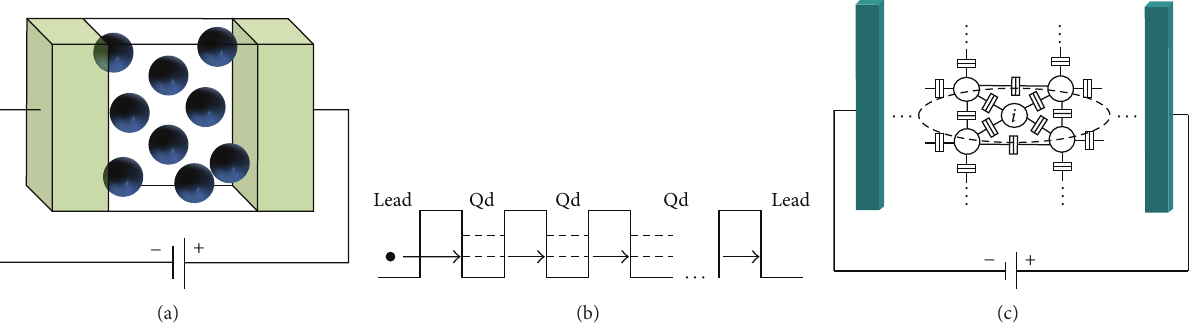
Figure 1: (a) The basic building block that forms the devices based on Qds: an array of Qds (they could be ordered or randomly dispersed) embedded in an insulator matrix sandwiched between two electrodes (leads). (b) Energy band scheme of the structure. The electron starts in the left lead and crosses through the dielectric matrix by tunneling processes assisted by the intermediate Qds. (c) Scheme of the equivalent electrical circuit of the device presented in (a). The Qds (circles) are connected between them and the leads (color blocks) by tunneling junctions. The tunneling junction is described as a capacitor in parallel with a current